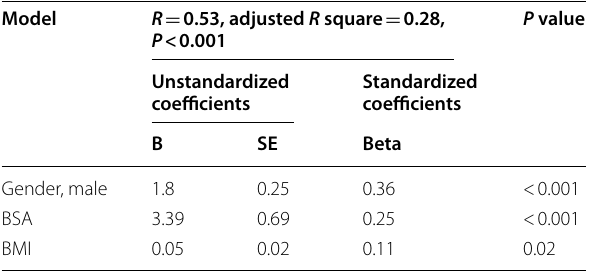
Table 25 Linear regression analysis to predict aortic annular